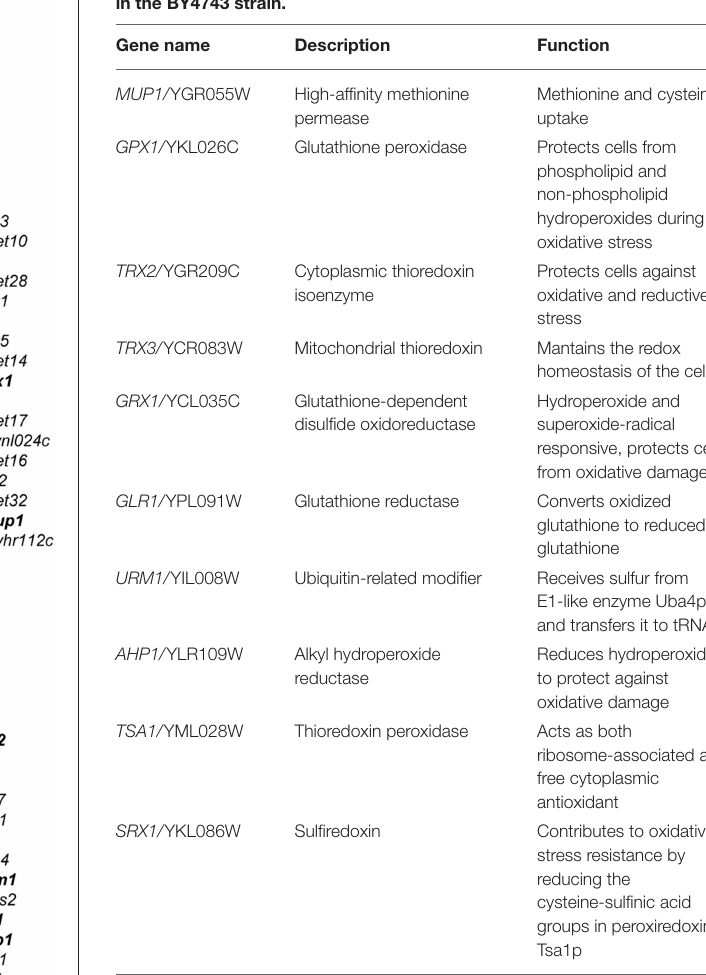
TABLE 2 | Selected genes with an affected phenotype at low temperature in the BY4743